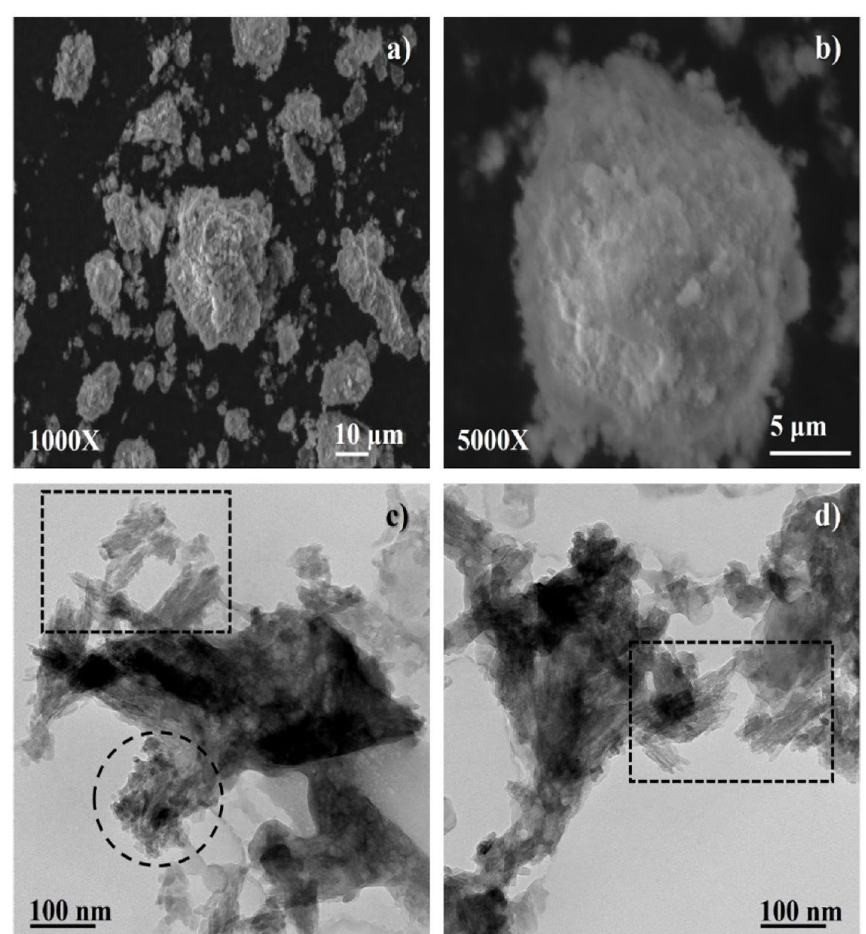
Fig. 3 SEM ( a and b ) and TEM ( c and d ) micrographs of